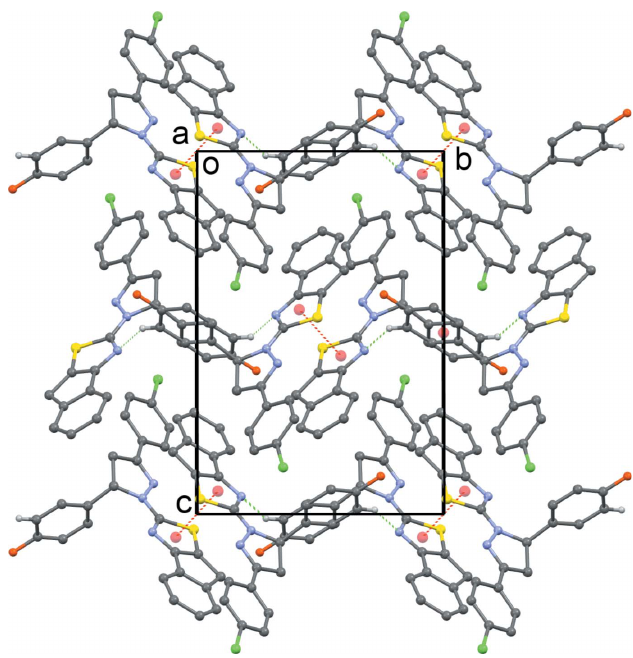
Figure 2 The crystal packing viewed along the a axis showing intermolecular contacts as dotted lines (C—H (cid:3)(cid:3)(cid:3) N in green and (cid:2) – (cid:2) in red) with some hydrogen atoms omitted for clarity.